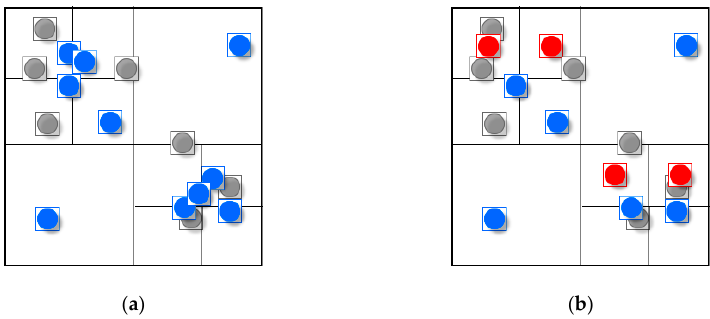
Figure 5. Preliminarily resolving conflicts among feature points by moving symbols to their grid center: ( a ) the blue symbols are feature points shown in Figure 4c; ( b ) once a symbol of feature point overlaps another one, both of them will be moved to their grid center, so that there will be no conflicts among the symbols of feature points.